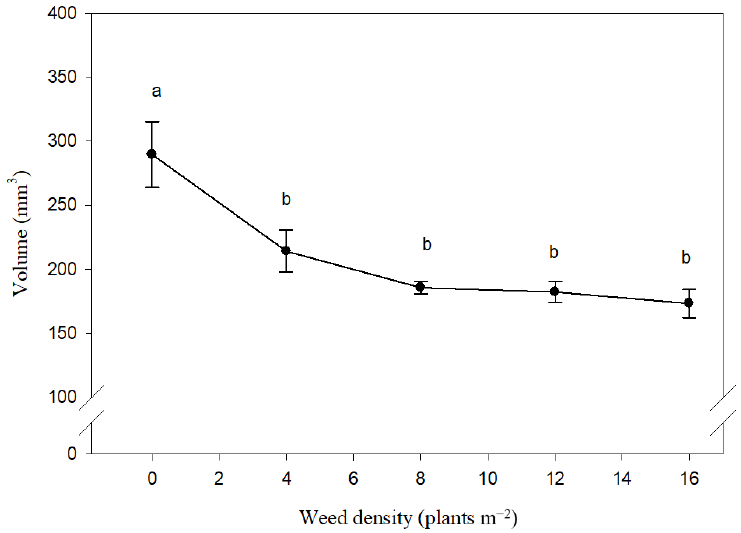
Figure 4. Effect of different density of Xanthium strumarium and Datura stramonium on maize seed volume. Mean values with the same letters are not significantly different based on Tukey’s studentized range test ( p ≤ 0.05). Vertical lines are standard error of mean ( n = 12; two years, two weed species and three replications).